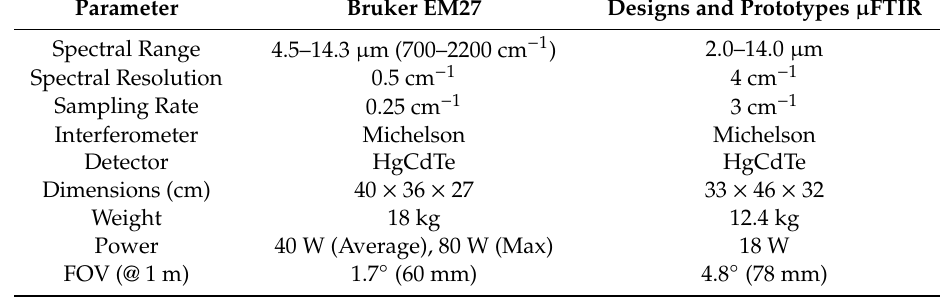
Table 2. Instrument specifications for the portable FTIR spectrometers deployed herein, namely a Bruker EM27 FTIR spectrometer and the Designs and Prototypes µ FTIR [31,40,60].